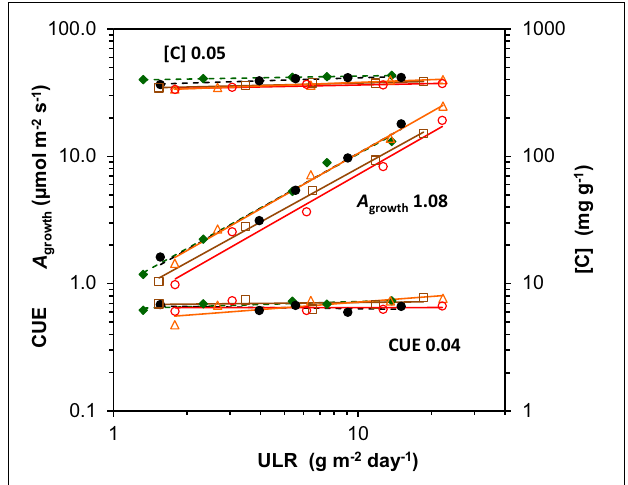
FIGURE 7 | Scaling slope analysis for each species of the contribution of its components to variation in unit leaf rate (ULR) across growth irradiances. The components are whole-plant gross photosynthesis per unit leaf area at the growth irradiance ( A growth ), whole-plant C-concentration ([ C ]) and the carbon use efficiency (CUE), the fraction of daily assimilated C invested in biomass (CUE = 1 − R/A ). The means were log-transformed and plotted against log-transformed ULR. The mean across species of the regression coefficients per component, depicting the average fractional contributions, are shown next to the regression lines. As the net assimilation rate calculated from gas exchange (NAR ge = A growth . CUE/[ C ]) is not necessarily fully identical with ULR, the fractional contributions ( A growth and CUE positive, and [ C ] negative) do not exactly add up to unity. Species are identified by their markers and regression lines (for the legend see Figure 1